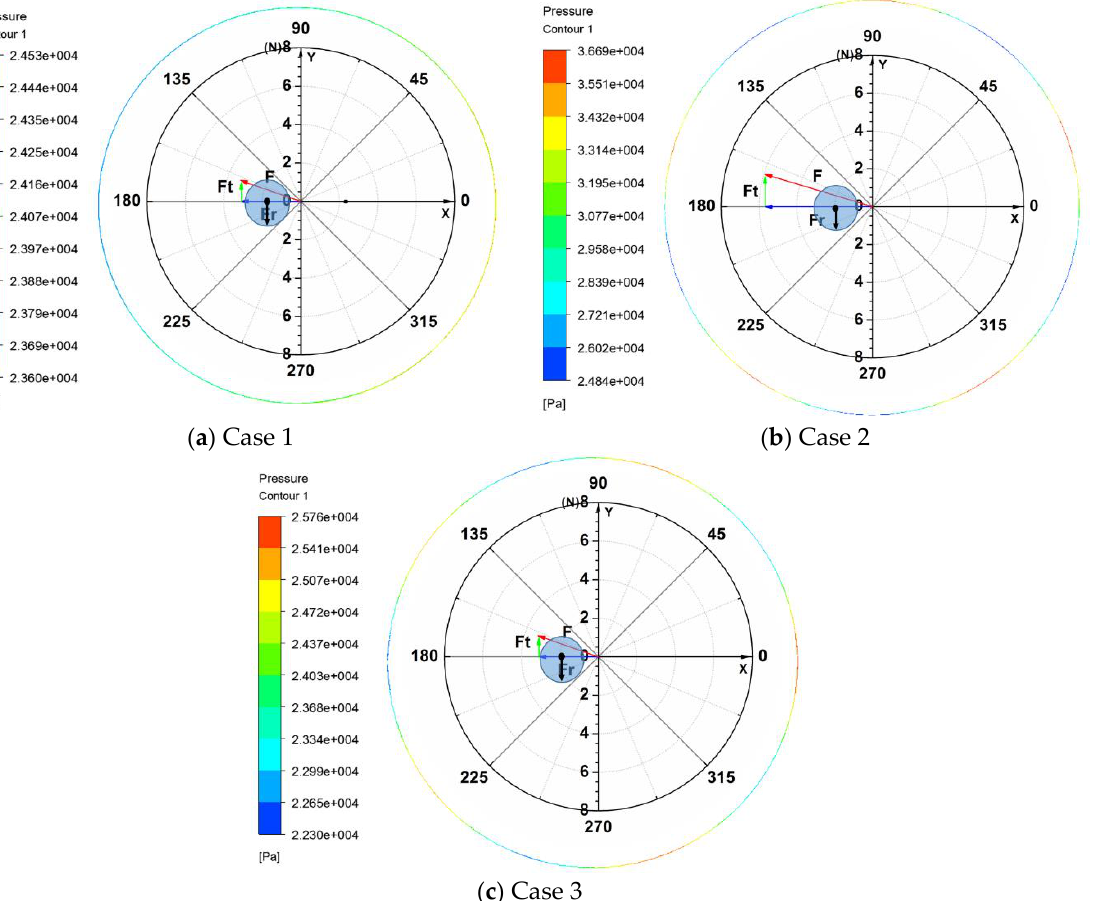
Figure 14. Static pressure contours in the meridional cross section of the annular seal in ( a ) Cases 1, ( b ) 2 and ( c ) 3 ( x excitation, t = 0.2 s, m = 5).